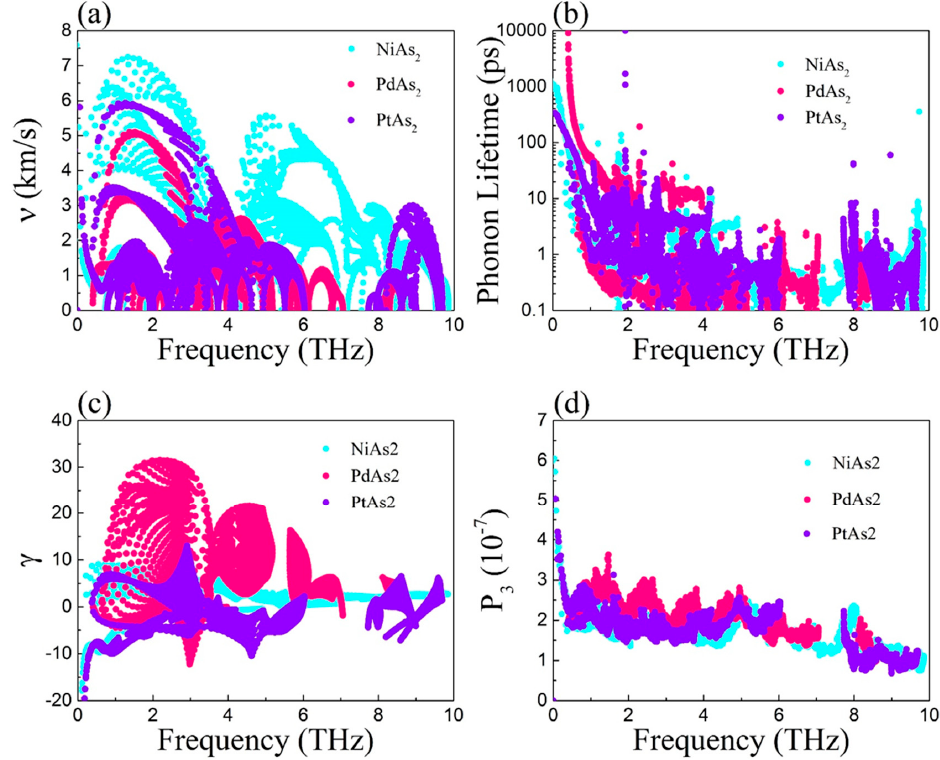
Figure 6. ( a ) Phonon group velocities, ( b ) phonon relaxation time, ( c ) Grüneisen parameters, and ( d ) P 3 phase space with respect to frequency for MAs 2